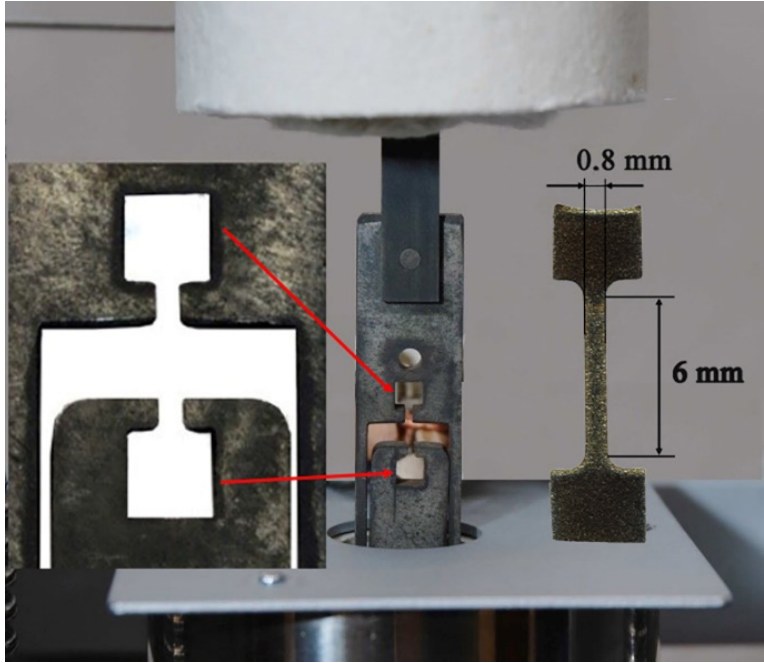
Figure 2. Special holders for the tensile test of the small samples.